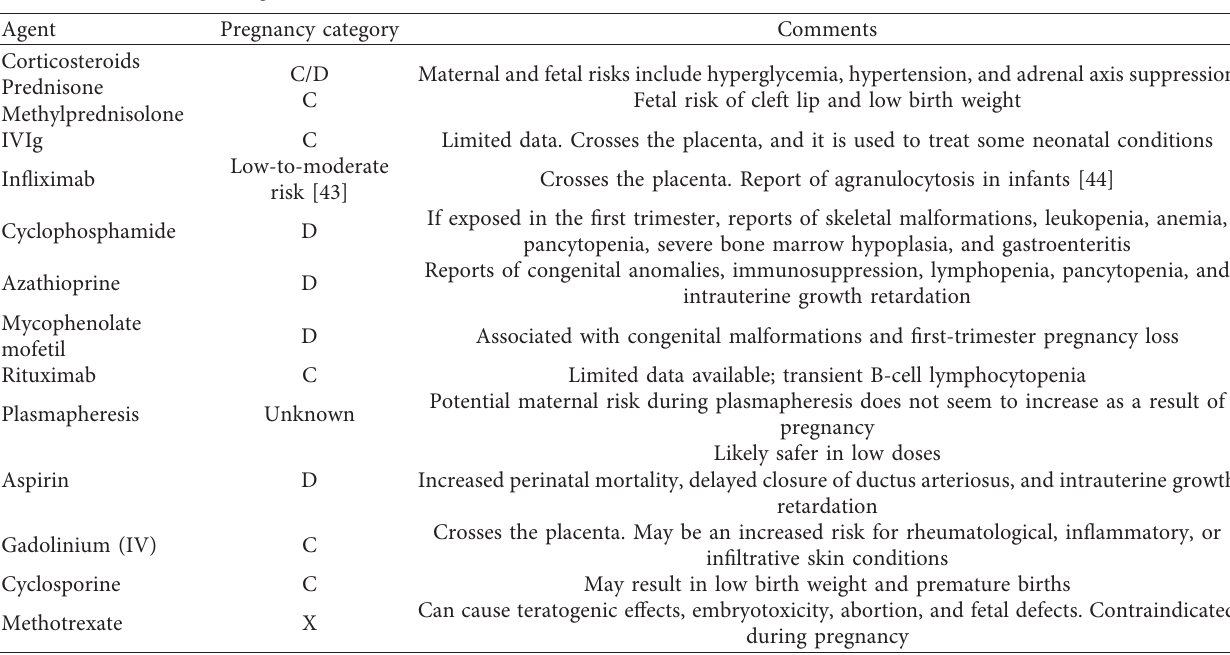
Table 1: Summary of several medications that are used in the treatment of Susac syndrome and their risk categories established by the United States Food and Drug